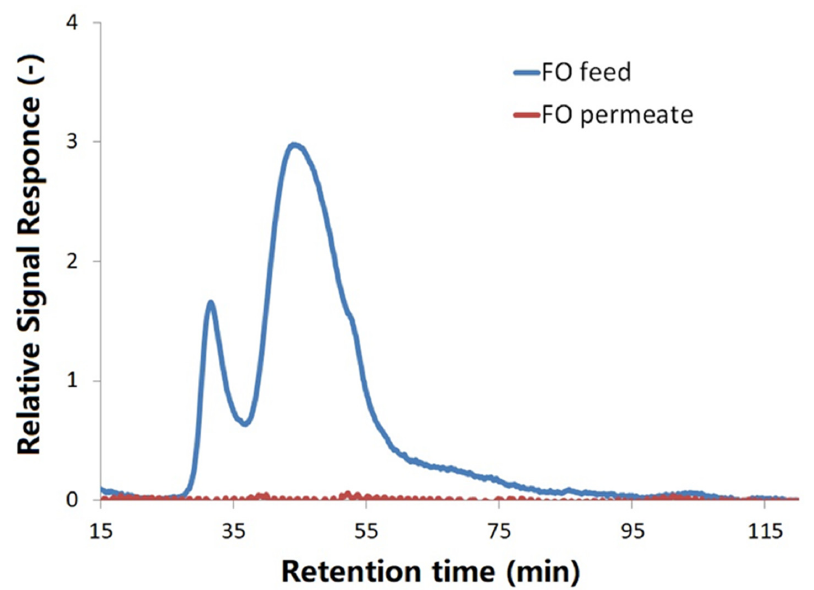
Figure 2. LC-OCD chromatograms of FDFO permeate (diluted draw solution) and initial feed solution with dissolved extracellular polymers released by two wastewater bacteria: Shigella flexneri strain 301 and Escherichia fergusonii ATCC 35469.